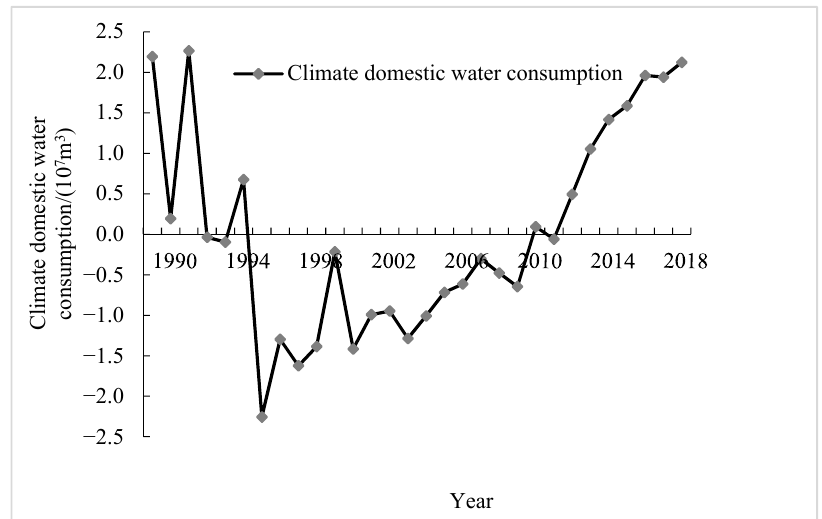
Figure 5. Variation of climate domestic water